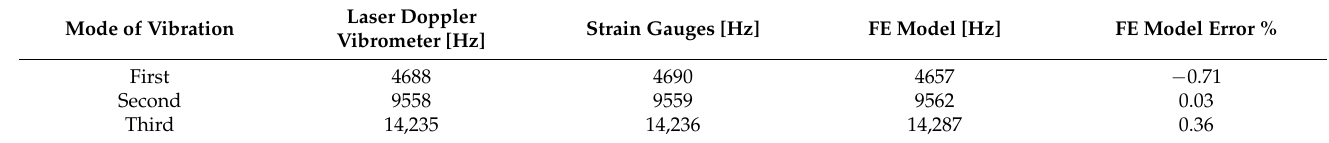
Table 3. Comparison between measured and computed axial